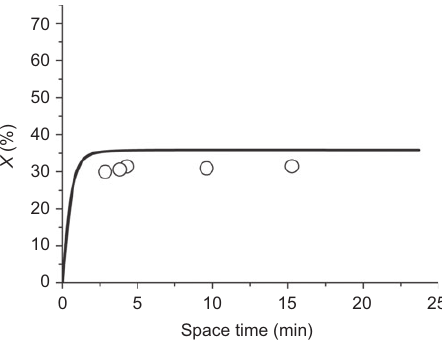
Figure 7 Conversion as a function of time for 21 bar at 433 K, = 0.4 m , C = 1.2 m for equilibrium conversion of 35%; the C 1,0 KHCO 3 ,0 simulation (solid dark line) results are compared with the experi- mental data